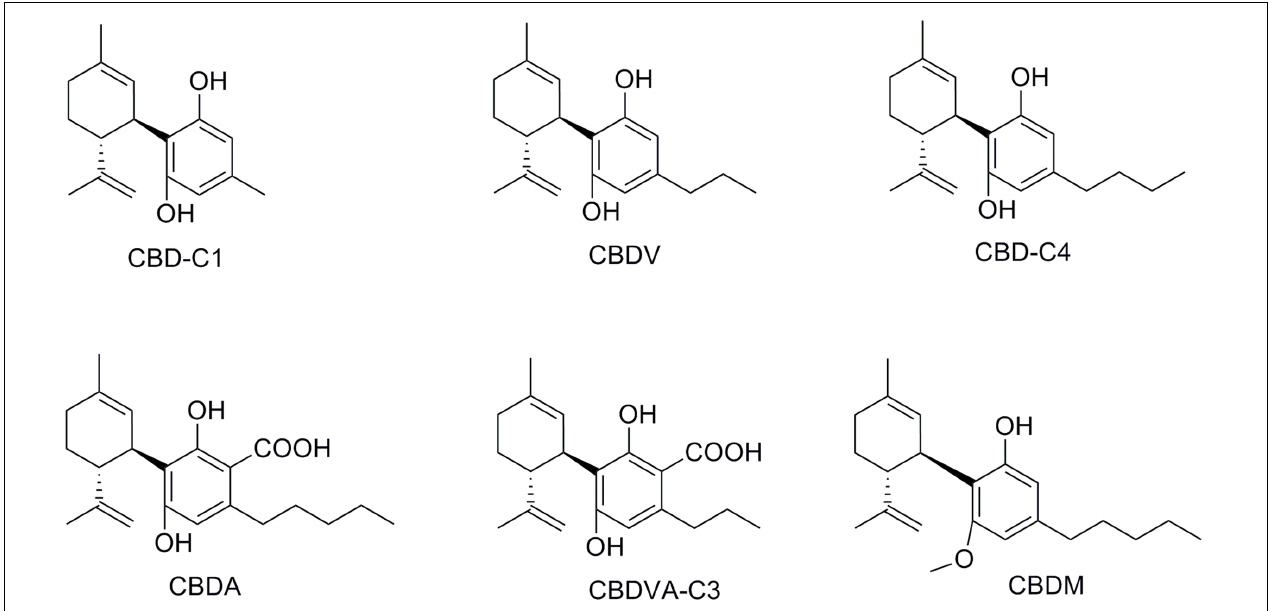
FIGURE 2 | Natural phytocannabinoid CBD